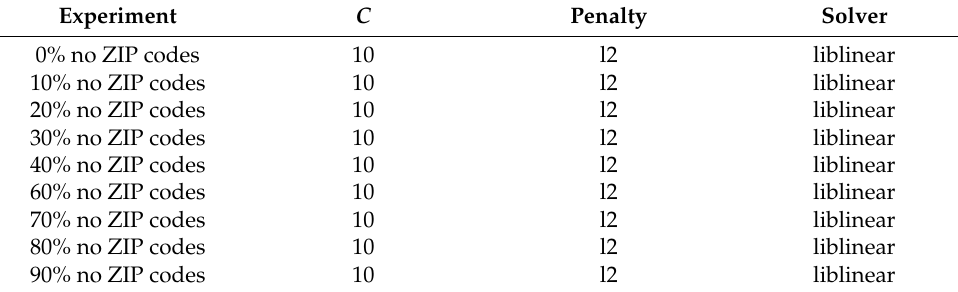
Table A2. Optimal hyperparameters for the LR.